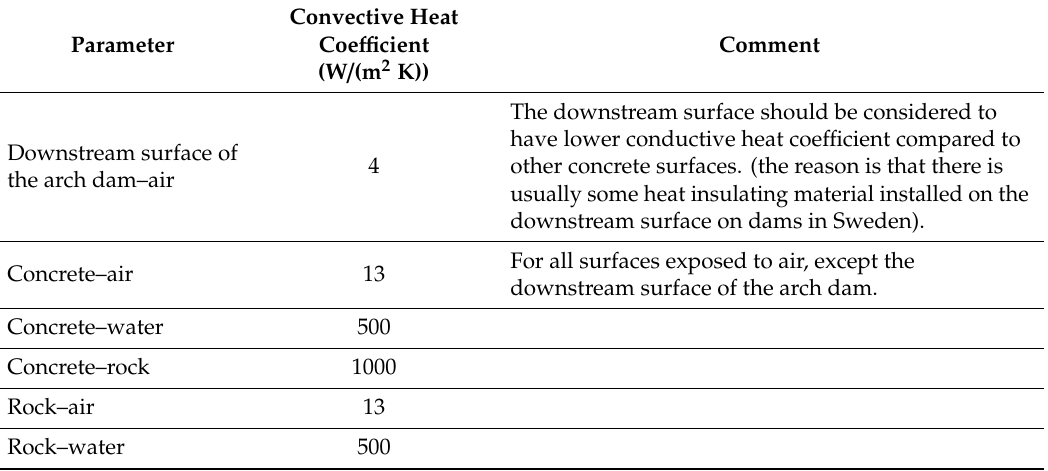
Table 1. Conductive heat coe ffi cients as given by [1].